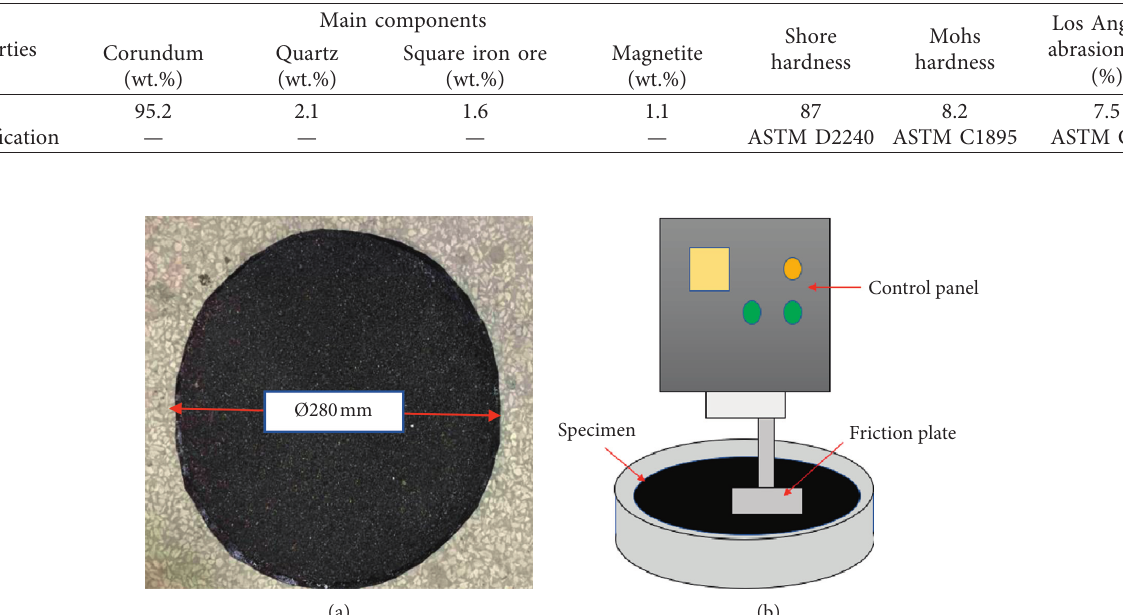
Table 3: Main components and properties of black corundum sand.